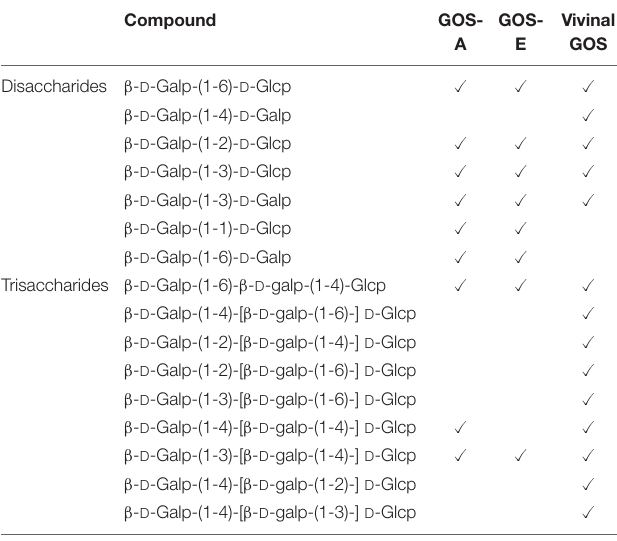
TABLE 5 | Comparison of di- and tri-saccharides from Purified GOS-A and Purified GOS-E (NMR analysis described in method) with Vivinal GOS according to Van Leeuwen et al.